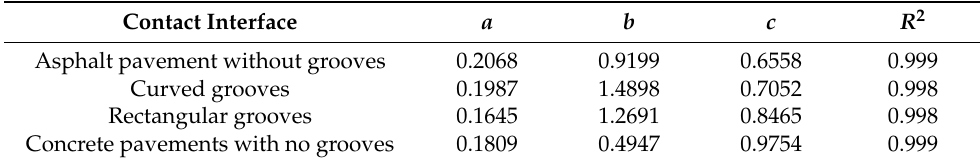
Table 1. Test results of stress distribution on different contact interfaces.